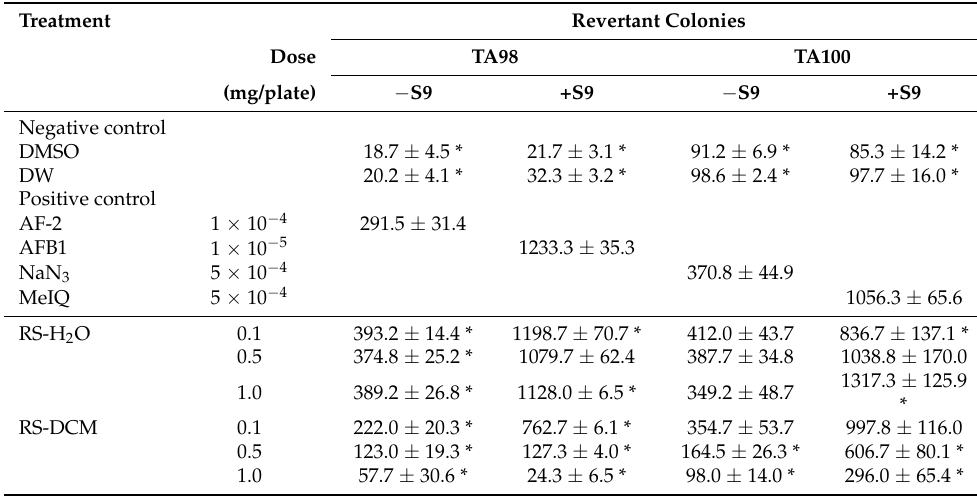
Table 7. In vitro antimutagenic activities of RS extract in TA98 and TA100 strains of S . Typhimurium with non-metabolic ( − S9) and metabolic (+S9)